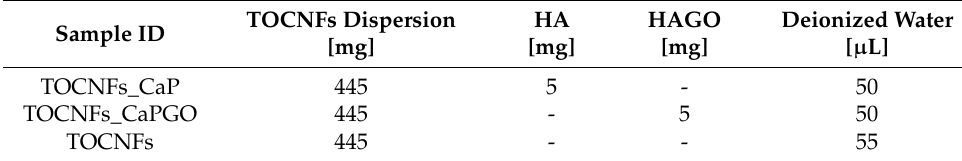
Table 1. Specimen’s